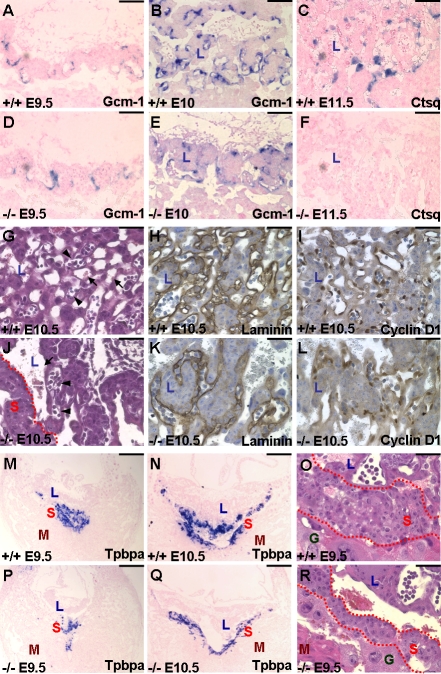
Developmental Defects of the SENP2-Null Labyrinth and Spongiotrophoblast LayersSections of E9.5–E11.5 placentas were analyzed by in situ hybridization of Gcm1 (A,B,D,E), Ctsq (C,F), or Tpbpa (M,N,P,Q) and counterstained with nuclear fast red (A–F,M,N,P,Q), by histology (G,J,O,R) and immunostaining of laminin (H,K) or cyclin D1 (I,L), and by counterstaining with hematoxylin (H,I,K,L).(A,D) The Gcm-1-positive trophoblast precursors localized to the invasion site were found in both the E9.5 SENP2+/+ and SENP2–/– placentas.(B,E) At E10, the SENP2 deletion caused an aberrant reduction in the Gcm-1 expressing cells. The Gcm-1-positive syncytiotrophoblasts failed to form an elongated multinuclear structure.(C,F) The Ctsq-positive cytotrophoblasts identified in the E11.5 wild-type labyrinth were missing in the mutant.(G,J) Arrows and arrowheads indicate maternal blood spaces surrounded by trophoblasts and fetal blood spaces surrounded by endothelia, respectively.(H,K) Laminin-labeled basement membrane, highlighting fetal blood spaces.(I,L) Cyclin D1 identified the proliferating endothelial cells.(M,N,P,Q) The number of the Tpbpa-expressing spongiotrophoblasts was drastically reduced by the loss of SENP2.(O,R) The thickness of the spongiotrophoblast layer, defined by broken red lines, decreased significantly.G, TGC; L, labyrinth; M, maternal decidua; S, spongiotrophoblast. Scale bars, 200 μm (A,D); 100 μm (B,C,E,F); 50 μm (G–L,O,R); 500 μm (M,N,P,Q).